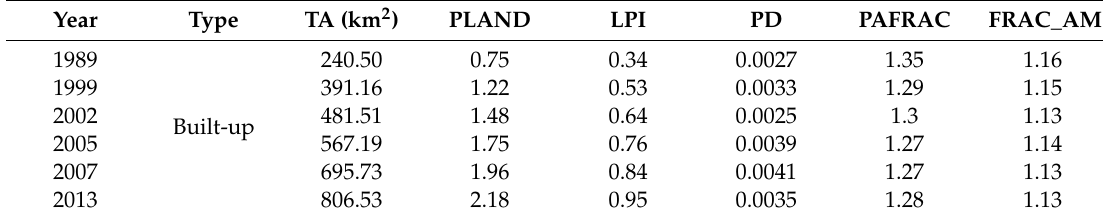
Table 8. Built-up area changes in the NXEZ (TA, PLAND, LPI, PD, PAFRC, FRAC_AM).